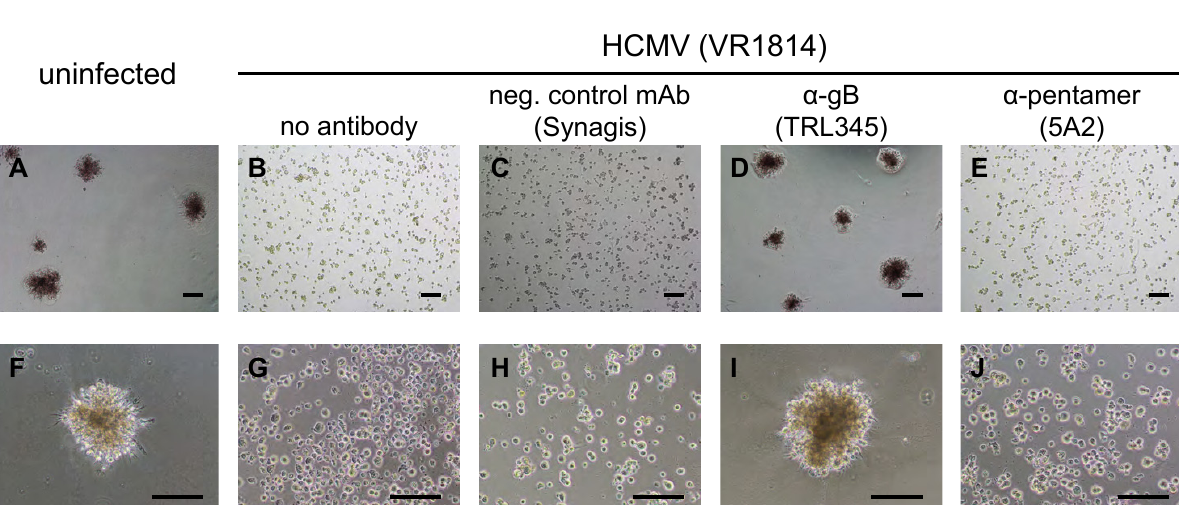
Figure 6. Neutralizing anti-gB mAb TRL345 precludes VR1814 infection and rescues TBPC differentiation. VR1814 was pretreated with 20 µg/mL of the indicated mAbs, and the mixtures were adsorbed to TBPCs. At 3 dpi, the cells were reseeded on matrigel and cultured in differentiation medium for 24 h followed by light microscopic analysis. Lower magnification photographs (upper panel), higher magnification photographs (lower panel). Scale bars = 200